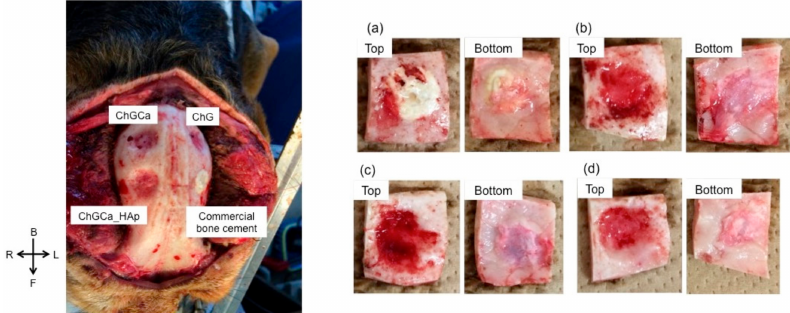
Figure 1. Photographs of Beagle skulls implanted with the samples after three years. On the left, the general appearance of a skull is shown, and, on the right, the appearance of each implanted position is shown. ( a ) commercial bone cement; ( b ) chitosan– γ -glycidoxypropyltrimethoxysilane (GPTMS) (ChG); ( c ) chitosan–GPTMS–CaCl 2 (ChGCa); and ( d ) chitosan–GPTMS with hydroxyapatite (HAp) (ChGCa_HAp).